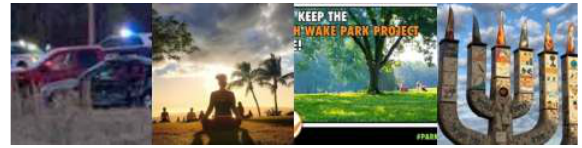
Fig. 4 Examples of aesthetic score prediction by the MobileNet (the score goes up from left to right).